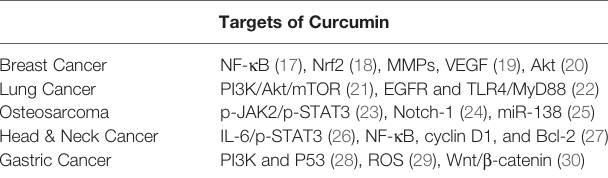
TABLE 1 | Targets of curcumin in anticancer treatments. Targets of